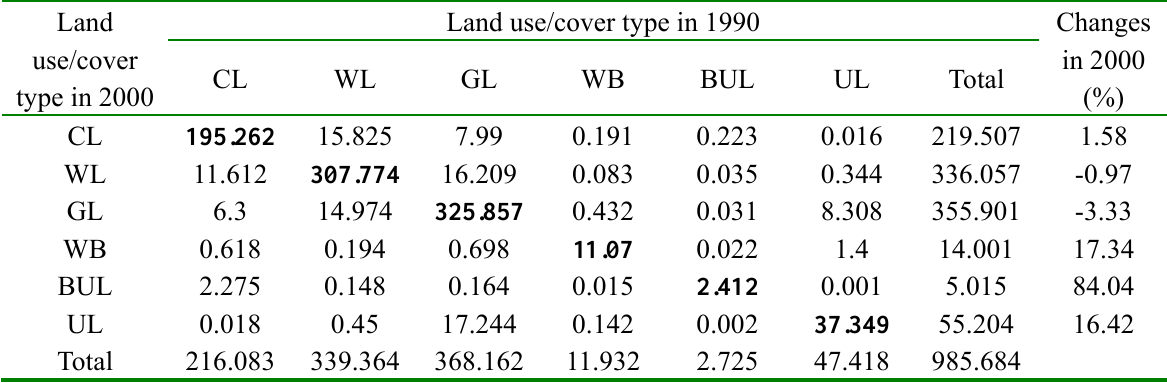
Unused land; the unchanged area of each land use/cover type was marked in bold. Table 2 . Transition matrix of each land use type in 1990 and 2000, and its change in 2000 (10 3 km 2